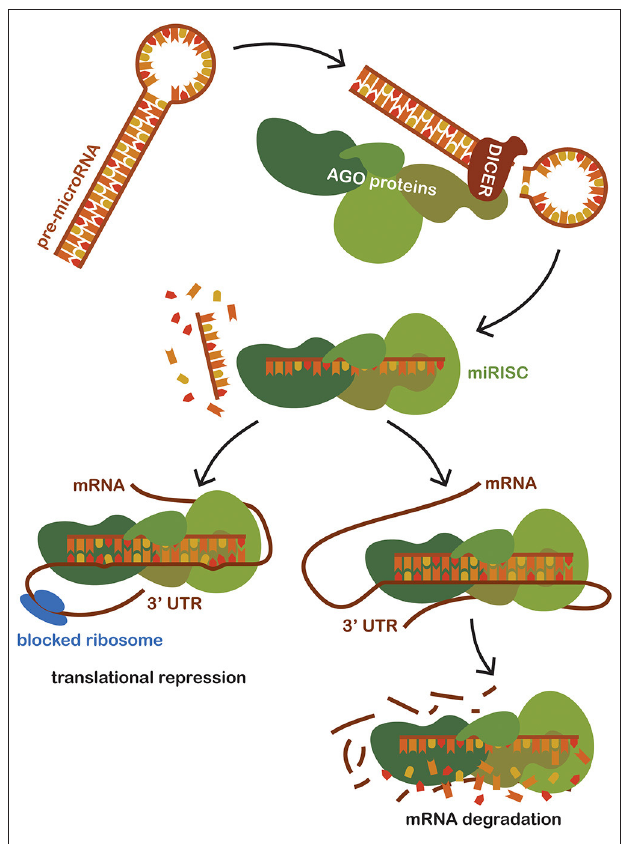
FIGURE 1 | Schematic representation of miRNA mechanism of action. Pre-miRNAs are exported to the cytoplasm from the nucleus and then processed by the Dicer (RNase III endonuclease). Dicer removes the terminal loop, and a mature miRNA is formed. Mature miRNA joins the Argonaut protein family (AGO), creating a miRNA-induced silencing complex (miRISC) which subsequently binds to the target mRNA. Targeting is based on the sequence complementarity between the 3’untranslated region of mRNA and the seed region of miRNA incorporated in the miRISC. The binding of miRISC leads to the destabilization of the target miRNA and repression of translation, thus impacting the amount of the final translated protein product of a given